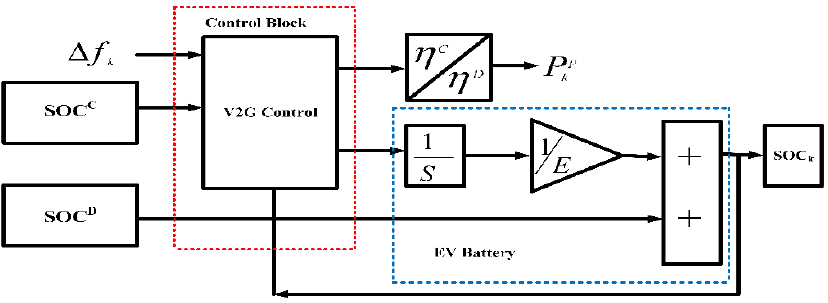
Figure 11. V2G control for primary frequency regulation .